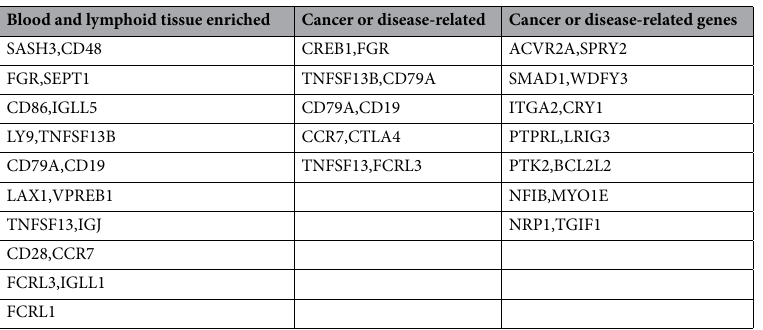
Table 1. List of genes and DNA promoter region-associated genes that are either tissue-specific, cancer-related or disease-related.